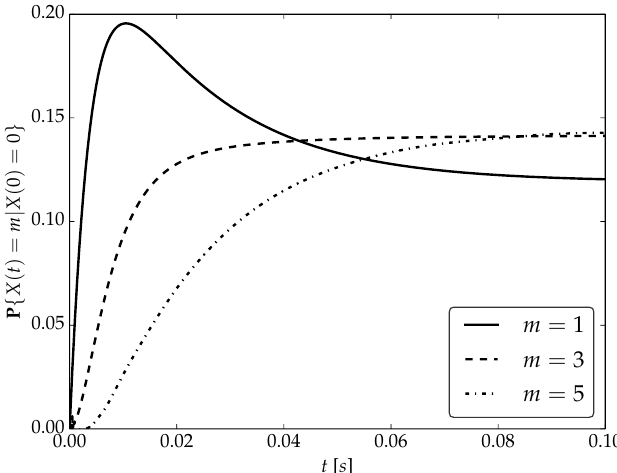
Figure 5. Transient probabilities P equal 2 ms.